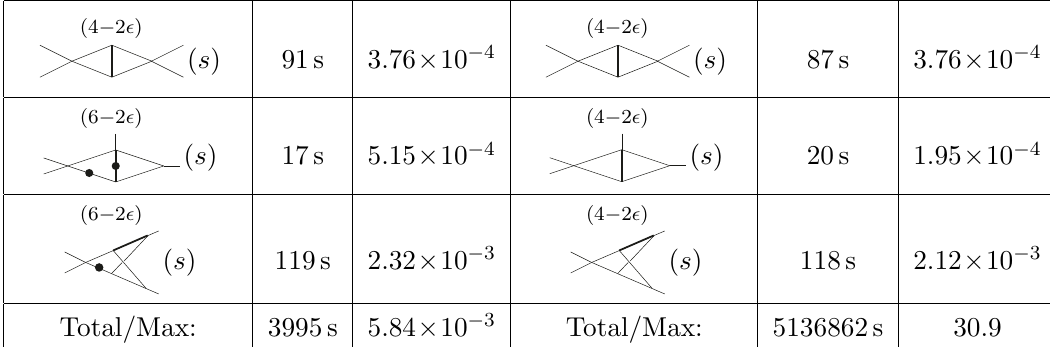
Table 2. Numerical performance of (cid:12)nite and conventional integral bases for two-loop mixed EW-QCD corrections to Drell-Yan lepton production in the physical region using SecDec 3 . For each integral in the above, the run time is given in seconds and the fractional di(cid:11)erence from the analytical solution is given for the expansion coe(cid:14)cient which (cid:12)rst gives rise to weight four multiple polylogarithms. In the (cid:12)nal row of the table, total run times and worst-case relative accuracies are recorded for both integral